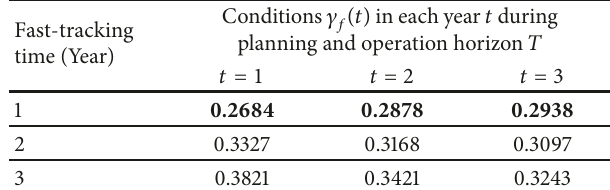
Table 7: Conditions for fast-tracking this rail transit line project in Scenario 3.